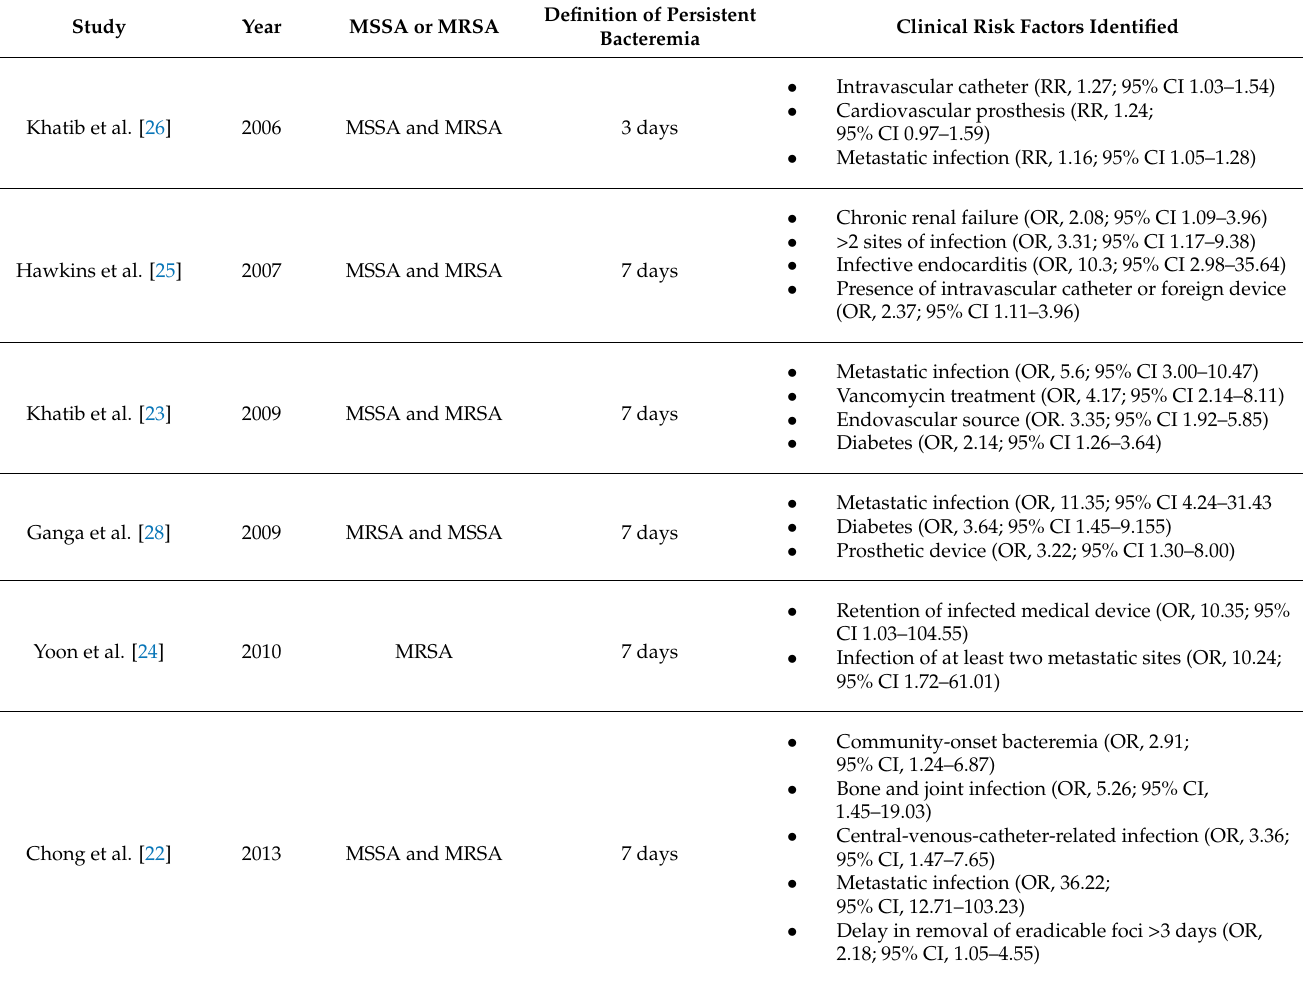
Table 1. Clinical risk factors for persistent